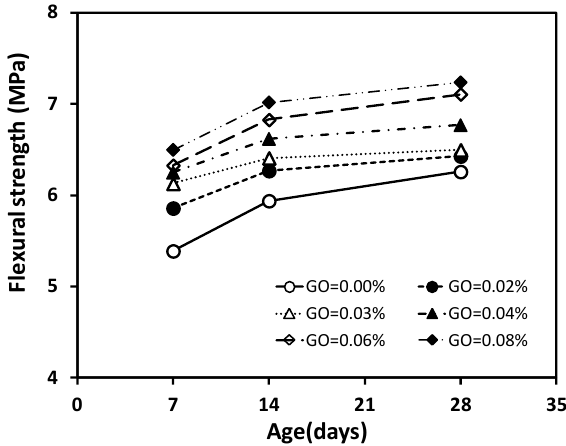
Figure 7. Flexural strength of concrete at di ff erent ages. Table 5. Flexural strength of concrete from the current study and as predicted by models (N / mm 2 ) 1 .